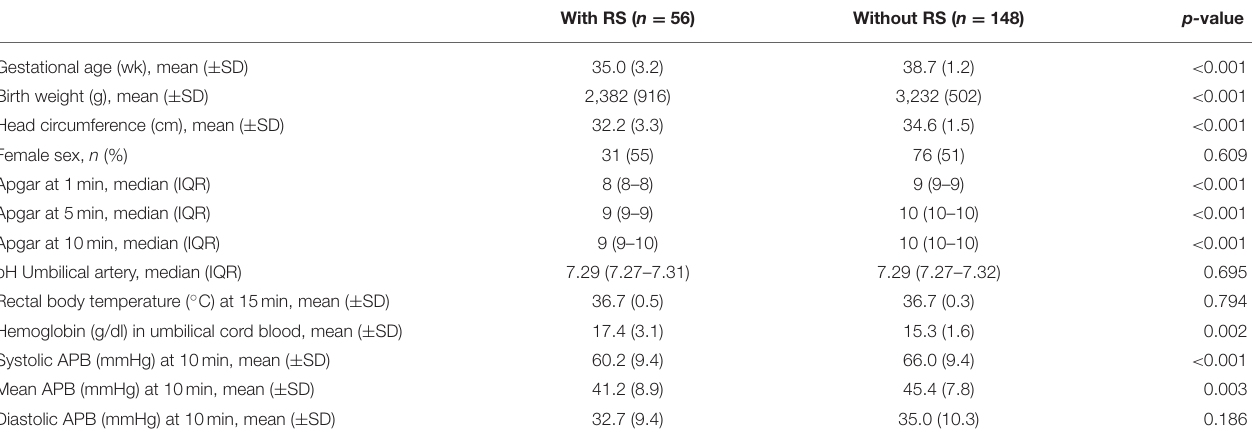
TABLE 1 | Demographic and clinical characteristics of newborn infants with and without RS.